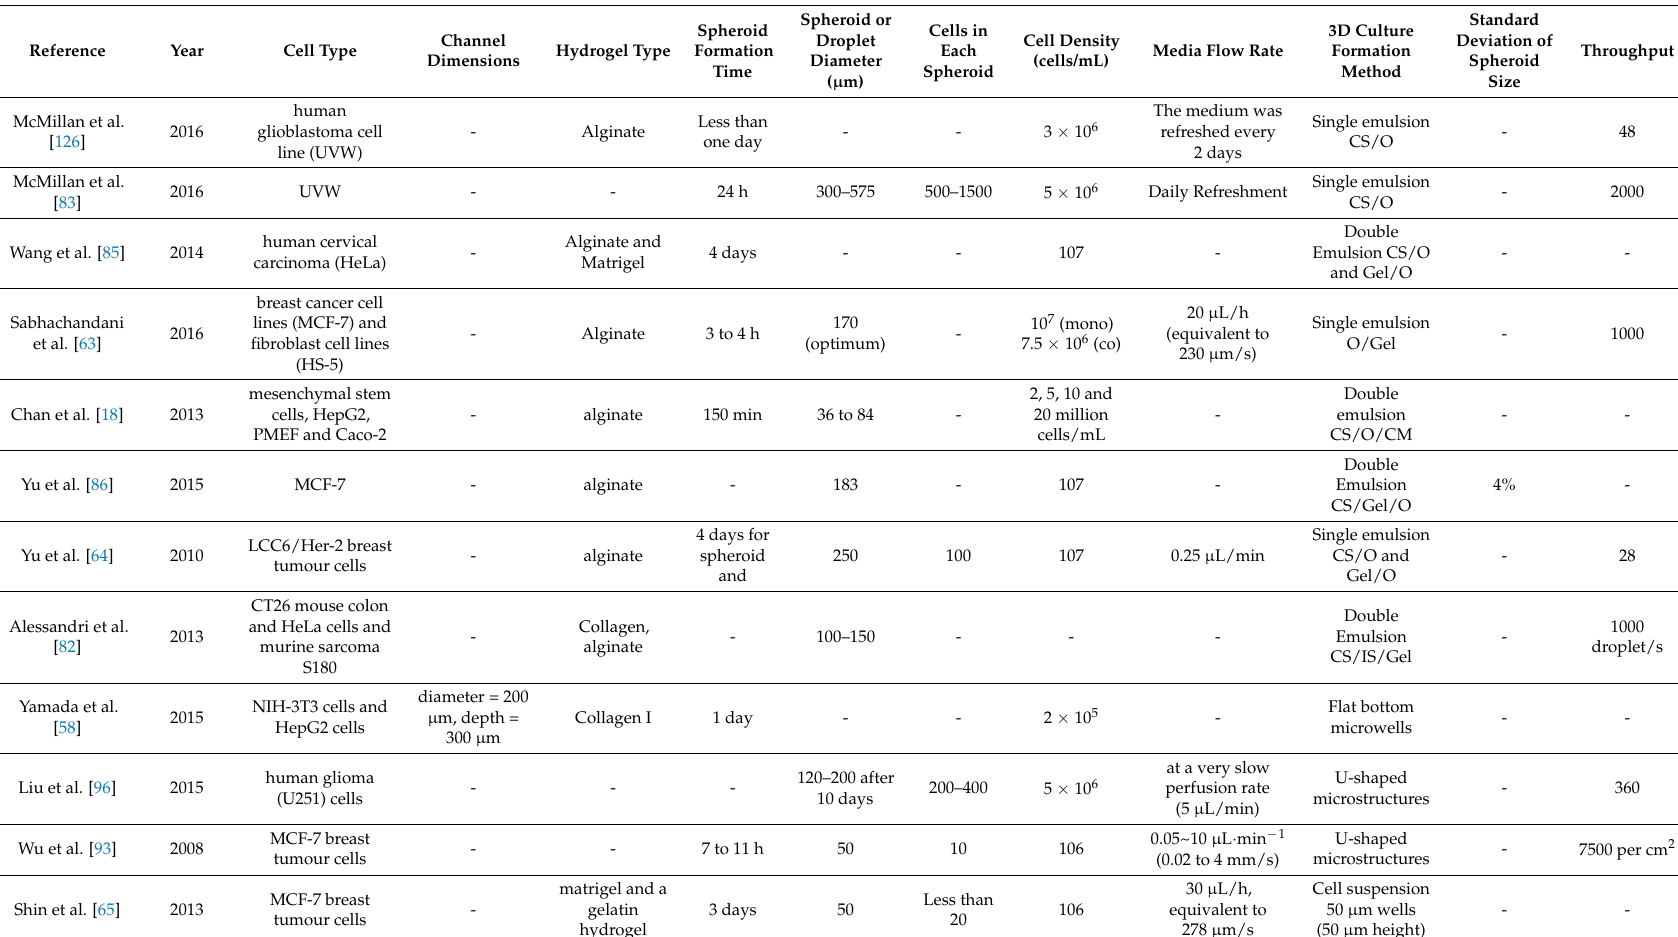
Table 1. The table is considered to represent the key variable elements in µ SFCs and µ SCCs. Those marked with * sign are µ